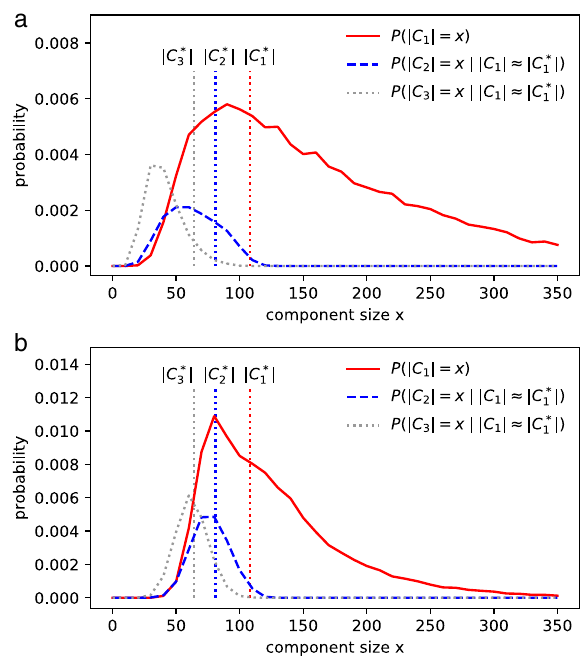
Figure 4. The distribution of the first 3 largest components in ER and PARG. n = 1628 in the PPI network. ( a ) The best fit of ER model, S tri =0.112 at p =1.035/n. ( b ) The best fit of G ( 11.148 521 , 1.225 / n ) , S tri =0.307 when p ∗ =1.20/n. The ground truth ( | C ∗ 1 | =108, | C ∗ 2 | =81, | C ∗ 3 | =64) in PPI network of S. cerevisiae is marked with vertical dotted lines. The details of realizations and definitions can be found in “Methods”